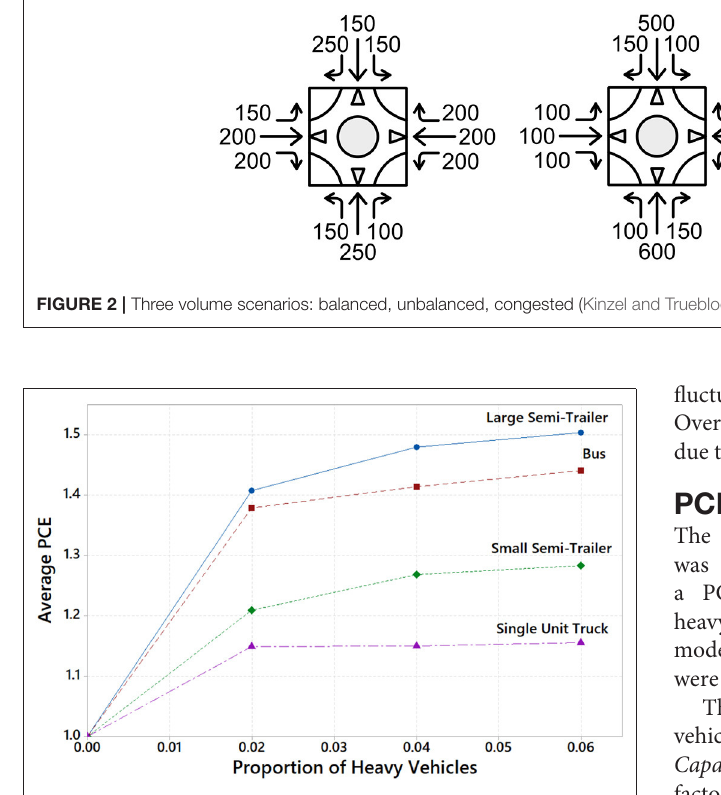
FIGURE 3 | Independent PCE values of four heavy-vehicle